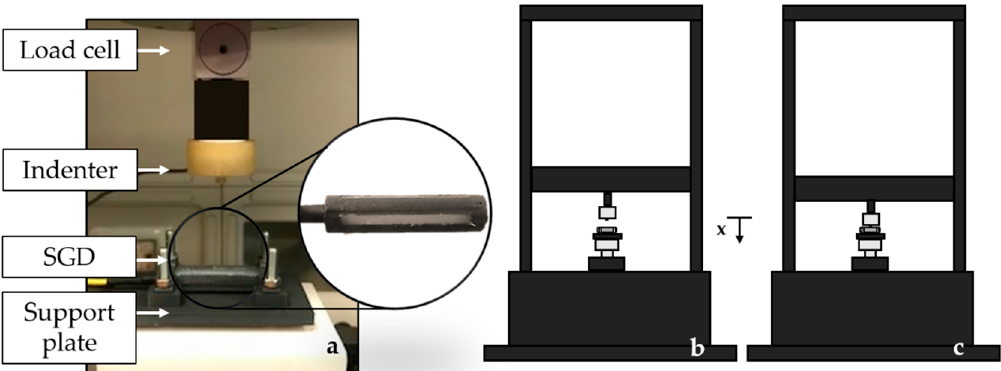
Figure 6. The SGD in the blocking system, the load cell, and the mechanical indenter are shown ( a ). A schematic representation of the SGD between the lower and the upper plates of the Instron machine is illustrated ( b ). The top plate moves at constant speed parallel to the x -axis ( c ).